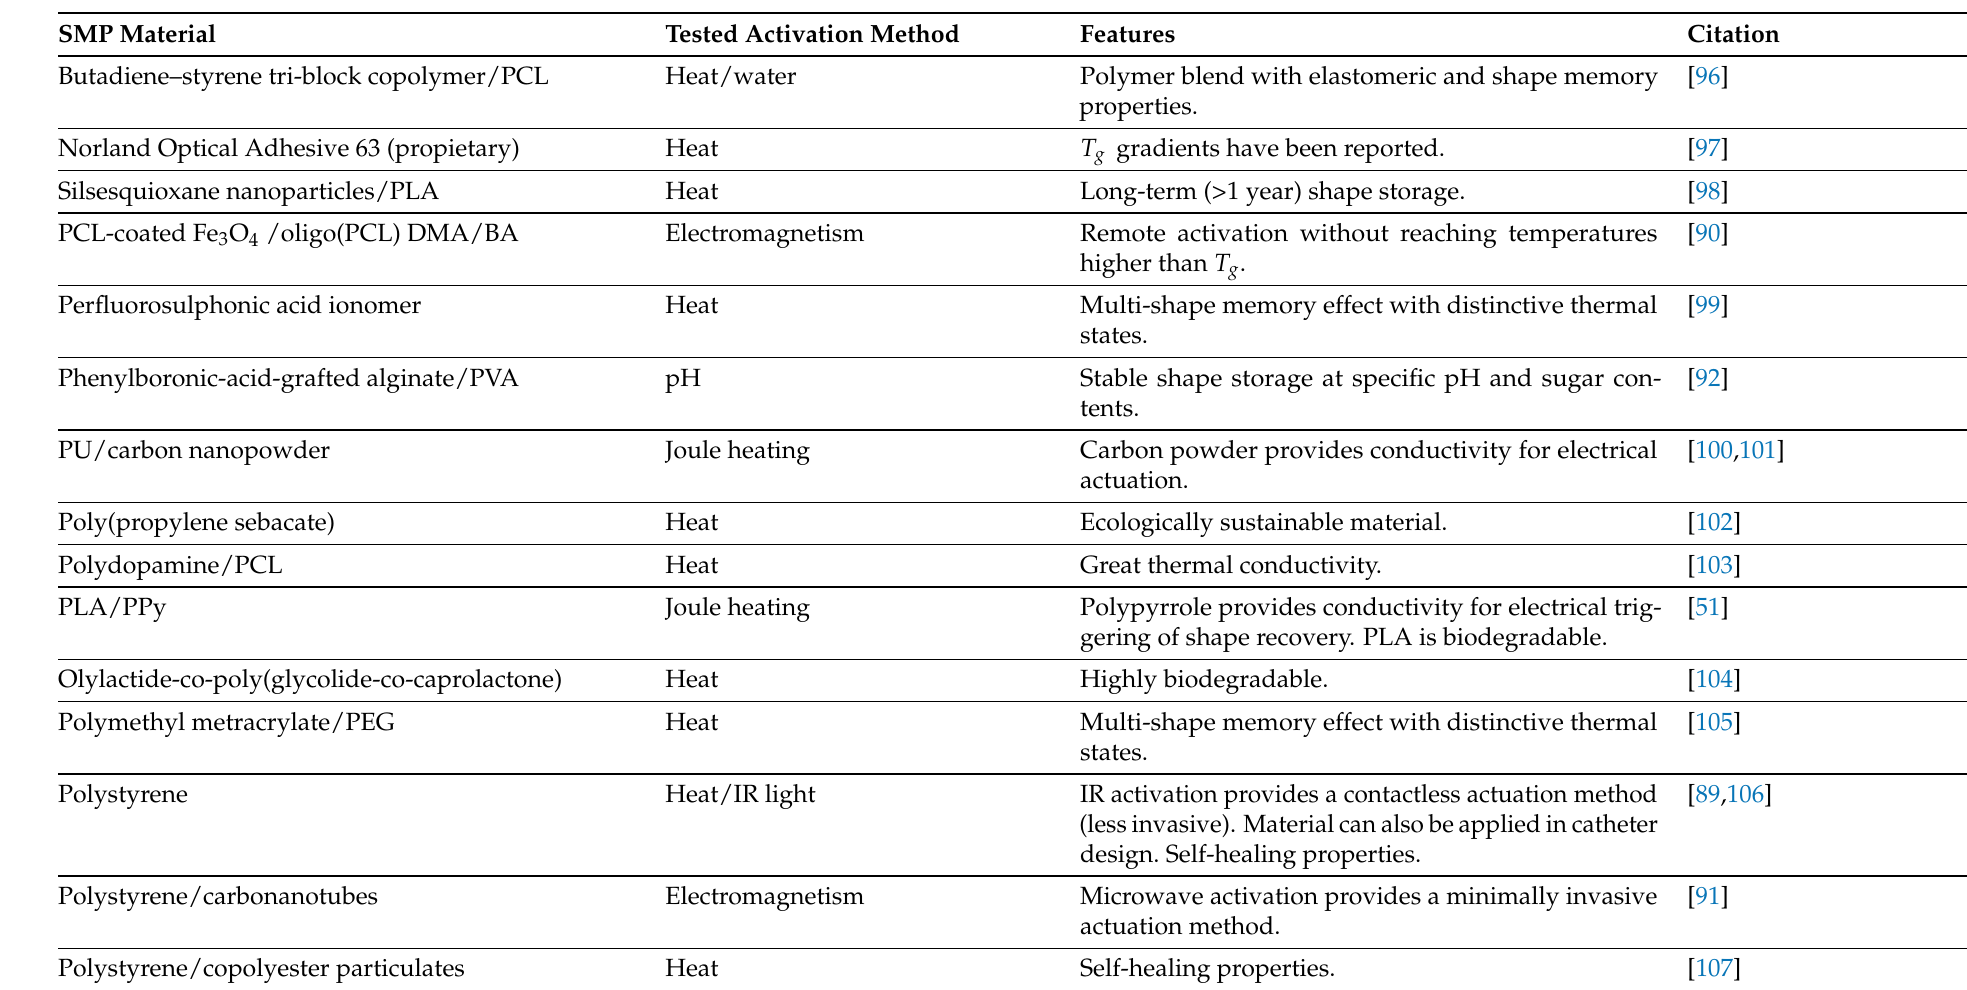
Table 2. Summary of materials with shape memory properties, their activation methods and the most outstanding reported